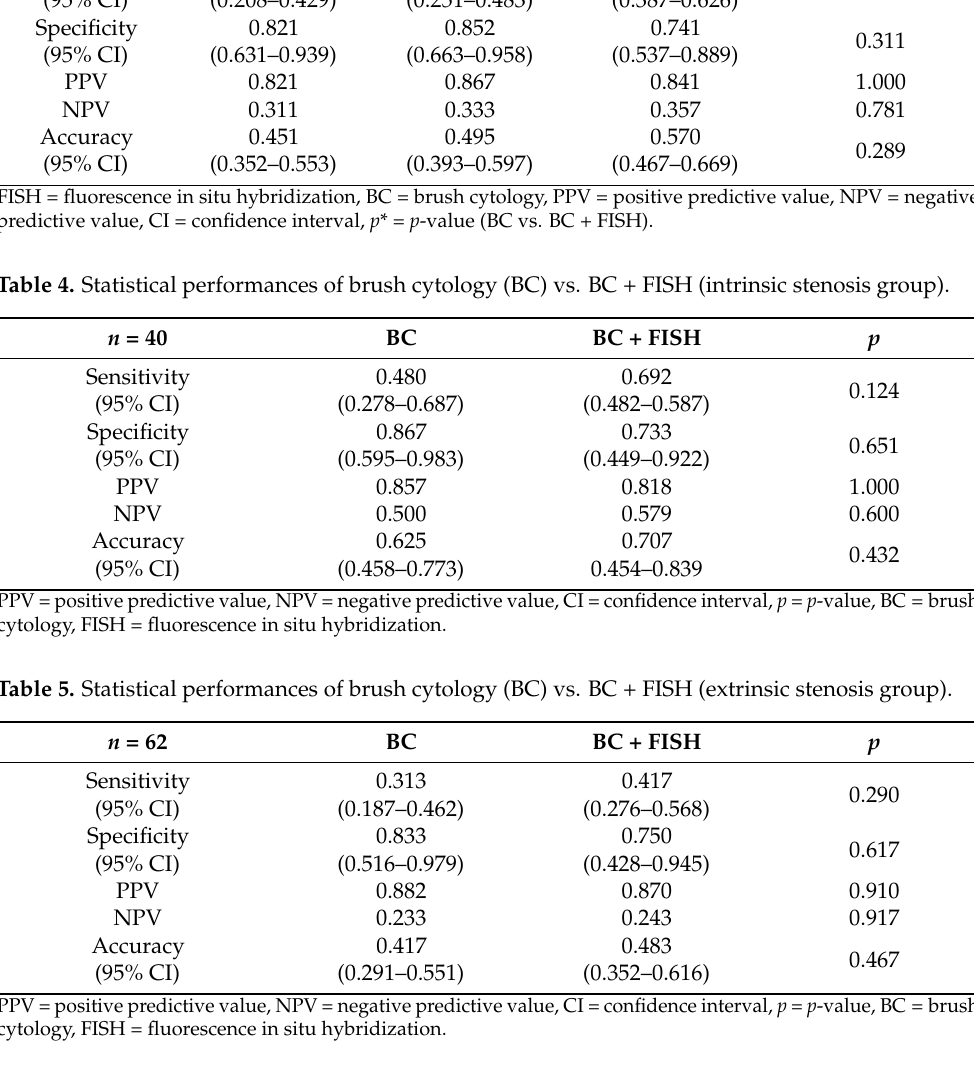
Table 3. Statistical performances of FISH, brush cytology (BC), and BC + FISH (overall study cohort). n = 102 FISH BC BC + FISH Sensitivity 0.311 (95% CI)